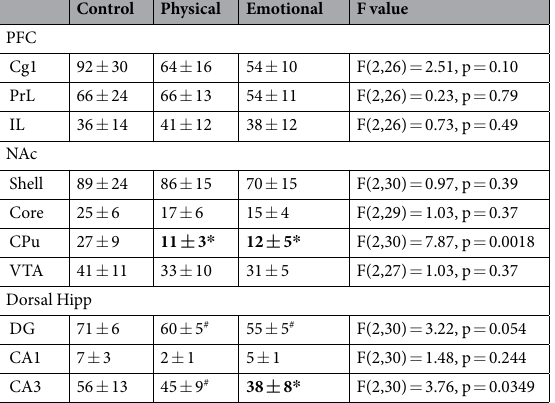
Table 2. Mean number ( + / − SEM) of cFos immunoreactive nuclei per mm 2 in brain areas of control, physical stress, and emotional stress mice 1 hr after social interaction testing (~24 hours after last day of 10d of chronic social defeat stress), n = 9–12 mice/group. Cg1, cingulate cortex; CA1/3, cornu ammonis 1/3; CPu, caudate putamen; DG, dentate gyrus; Hipp, hippocampus; IL, infralimbic cortex; NAc, nucleus accumbens; PFC, prefrontal cortex; VTA, ventral tegmental area. * p < 0.05, compared to control. # Non-significant